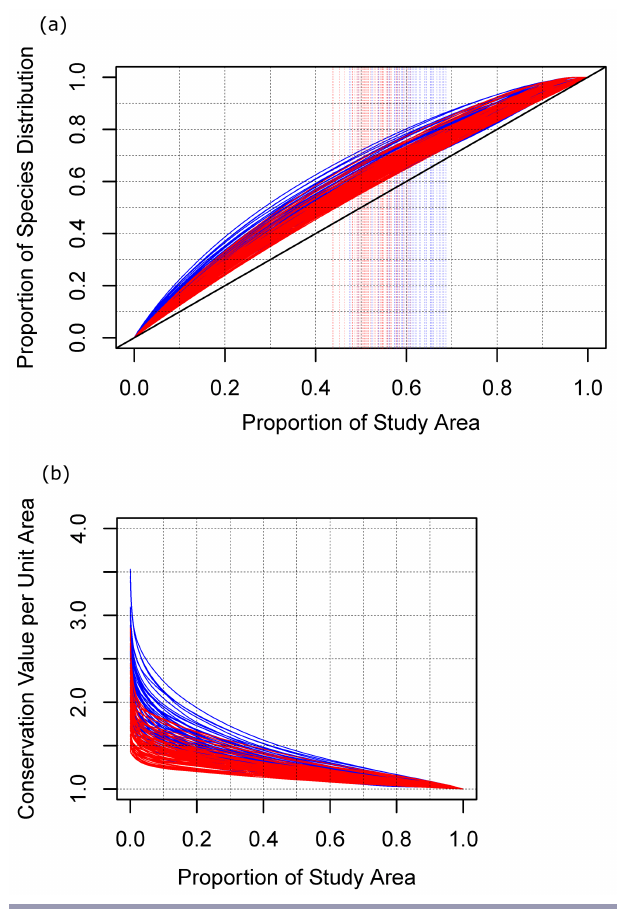
Fig. 9 . Performance curves for all 128 scenarios (blue = diversity-focused, red = representation-focused), representing (a) additive efficiency, the weighted average proportion of species conservation value (abundance) conserved by a given proportion of the study region, and (b) proportional efficiency, the ratio of bird conservation value to land area across study region thresholds. Vertical lines indicate study region proportions where additive efficiency, as shown by corresponding horizontal lines, is highest for a given scenario. See Table A6.1 for further